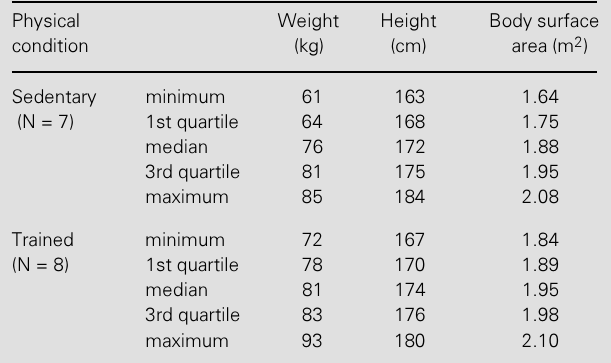
Table 1 - Anthropometric characteristics of the groups